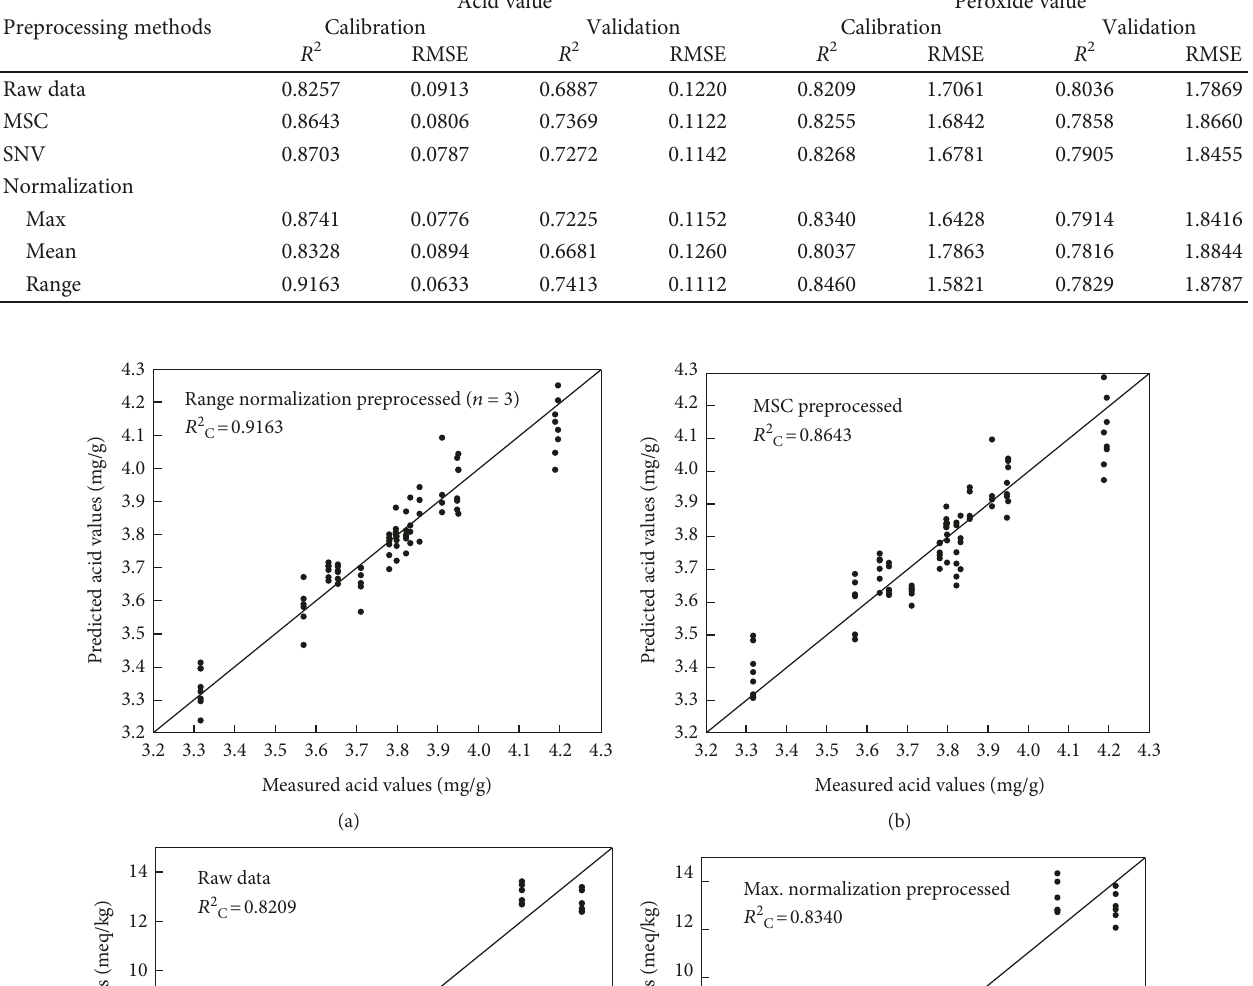
Table 4: Results of PLSR calibration and validation for acid and peroxide values of perilla seed oil according to preprocessing methods. Preprocessing methods